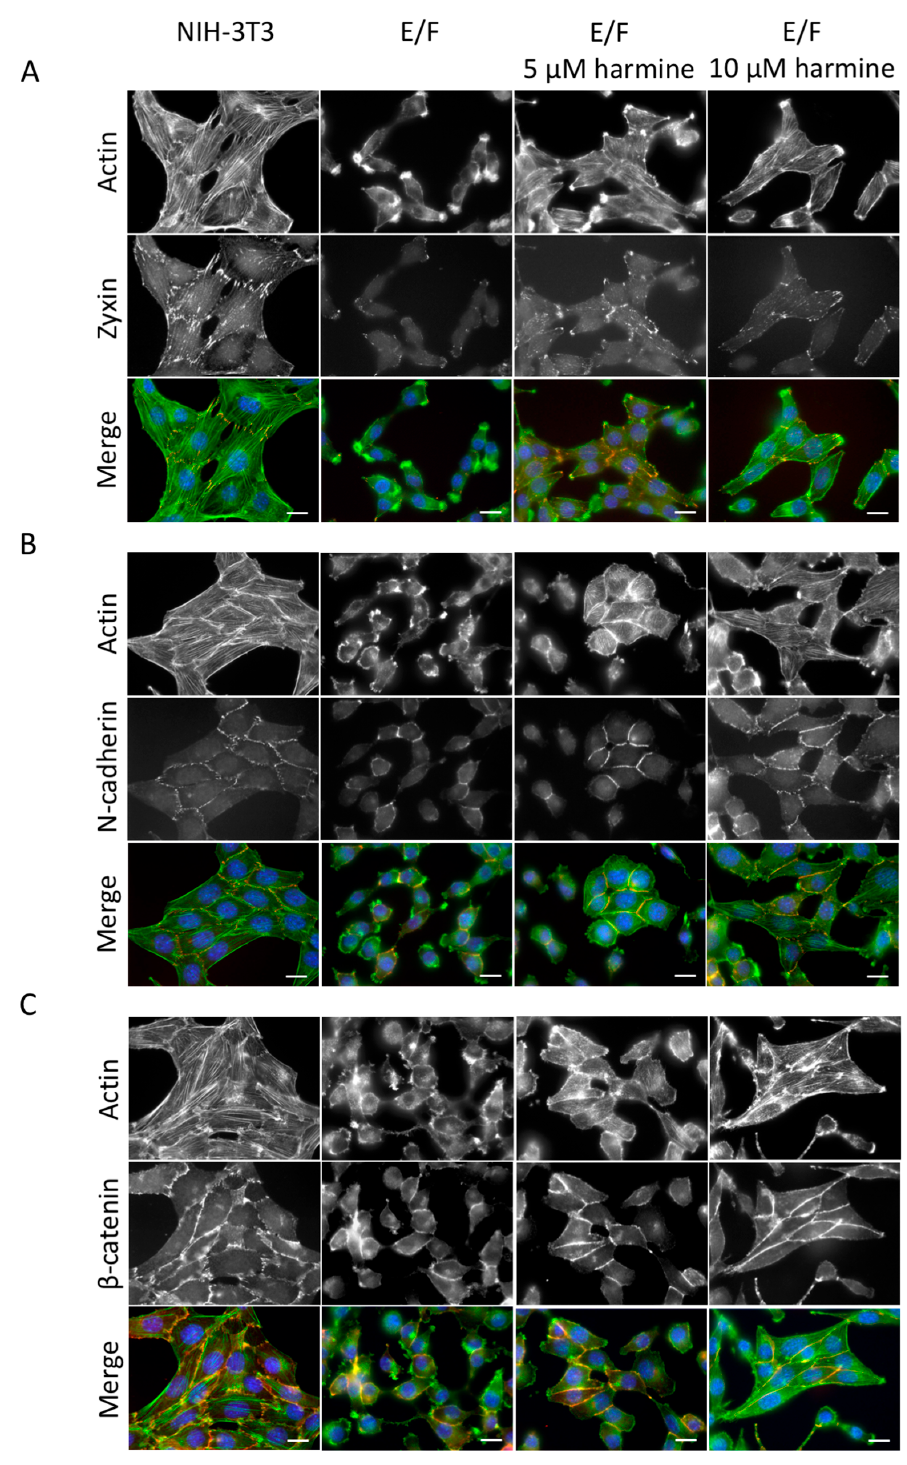
Figure 2. Effect of harmine on E/F cell morphology and cell–cell adhesion. NIH-3T3 and E/F cells were cultured in the absence or presence of 5 µM or 10 µM harmine, as indicated. After 72 h of culture, the cells were fixed, permeabilized and co-stained for actin with one of the following adhesion-related proteins; zyxin ( A ), N-cadherin ( B ) or β -catenin ( C ). Cell nuclei were stained with DAPI. Then, the cells were analyzed with a fluorescence microscope. In the merged images, actin is presented in green, zyxin, N-cadherin and β -catenin in red and nucleus in blue. Images are representative fields from three independent experiments. Scale bars: 10 µm.